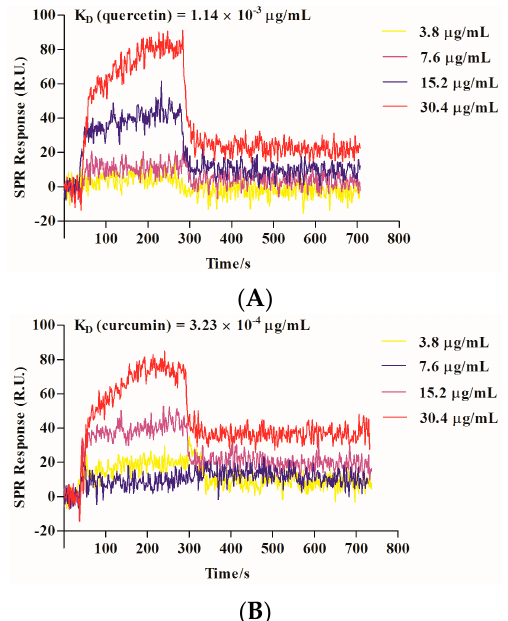
Figure 4. The interaction between the influenza HA and quercetin was analyzed with PlexArray HT systems. ( A ) The binding curve of quercetin with HA protein in SPR assay; ( B ) The binding curve of curcumin with HA protein in SPR assay. The compounds were immobilized on a sensor chip, and the recombinant influenza HA protein was injected as analytes at various concentrations dissolved in a running buffer at a flow rate of 3 μ L/s. The contact time and dissociation time were 300 s respectively. The chip platform was regenerated with gly-HCl (pH 2.0) and washed with the running buffer. Curcumin was used as a positive control in this assay. The affinity constant K D is the ratio of dissociation constant K d with association constant K a , K D = K d /K a .